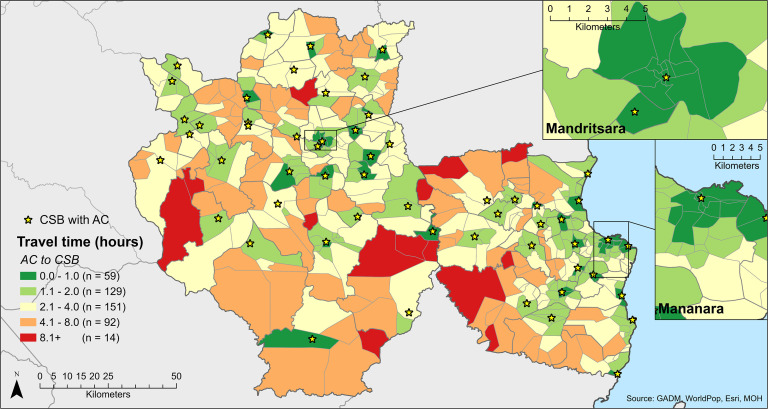
Estimated Travel Time for AC From Each Fokontany to Their Assigned CSB by Foot During the Dry Season (1 Way)Abbreviations: ACs, agents communautaires (community health workers); CSB, centres de santé de base (health centers).